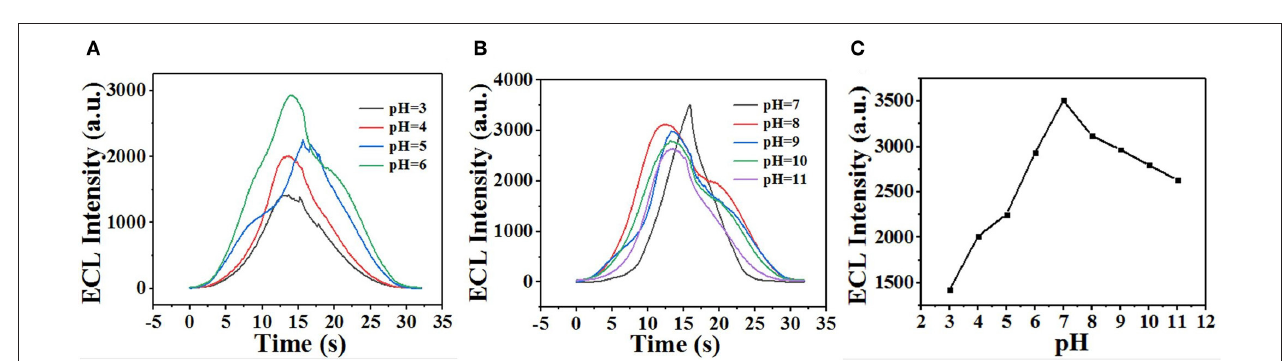
Frontiers in Chemistry |